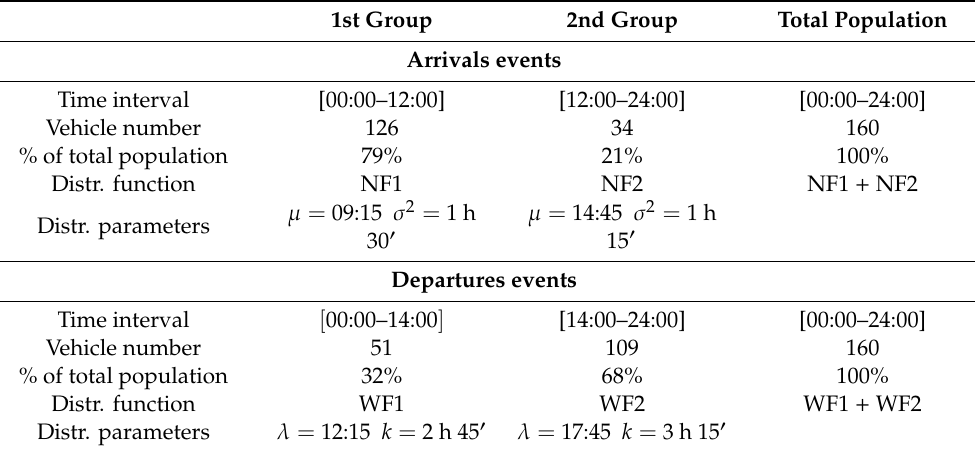
Table 3. Arrivals and departures: data and distribution